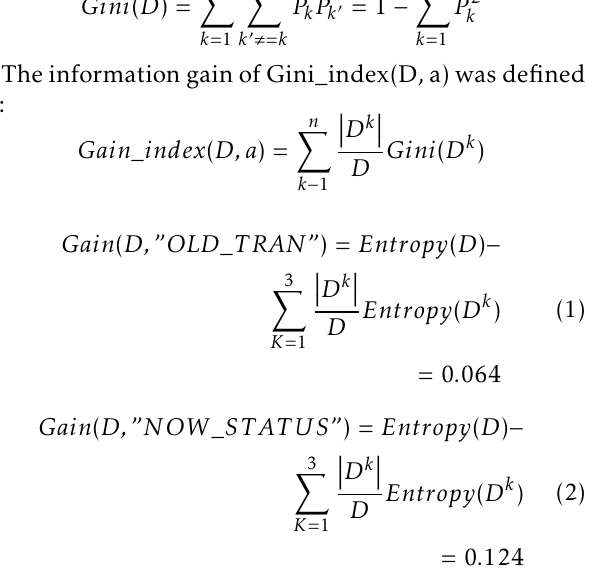
Fig. 4 . The average power consumption over different RSSIs